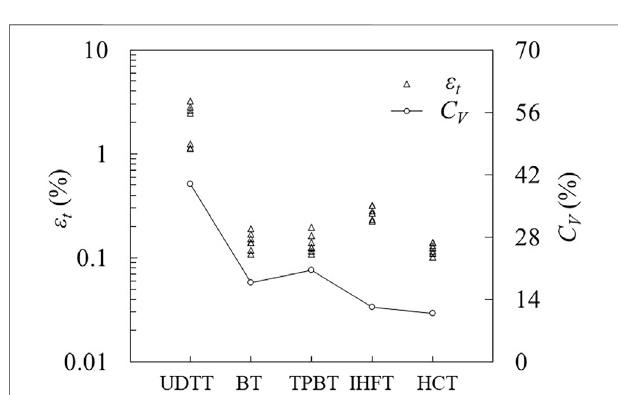
FIGURE 7 | Average tensile strengths and stains obtained from different test methods.